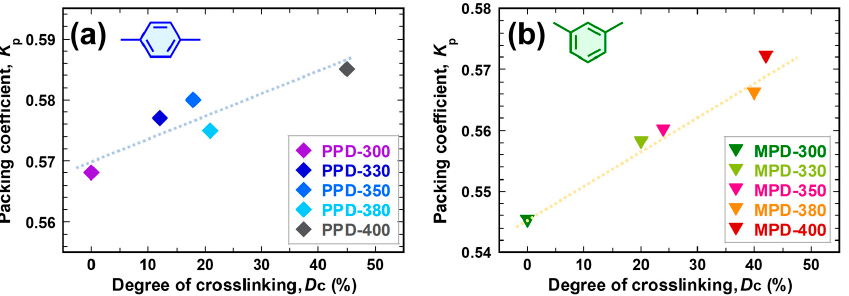
Figure 5. Relation between the degree of crosslinking ( D C ) versus molecular packing coefficients; K p for ( a ) PPD-PIs and ( b ) MPD-PIs.